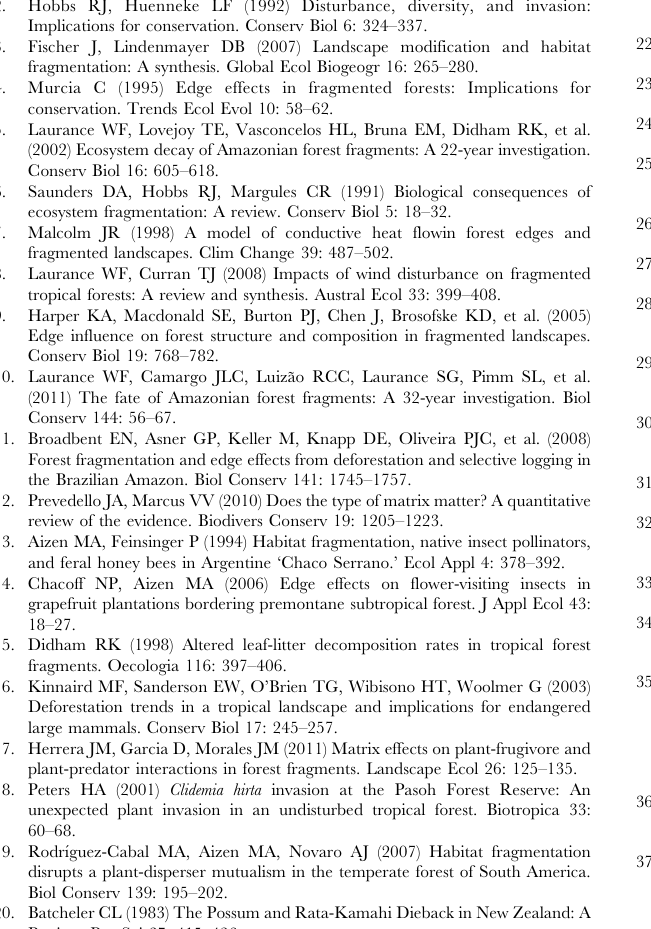
Table S2 Results of the estimated posterior distribu- tions from our hierarchical Bayesian model. The symbols in left-most column correspond to those used in the model (see Methods section, Text S1). Significant parameters, whose 95% credible interval does not incorporate zero, are in